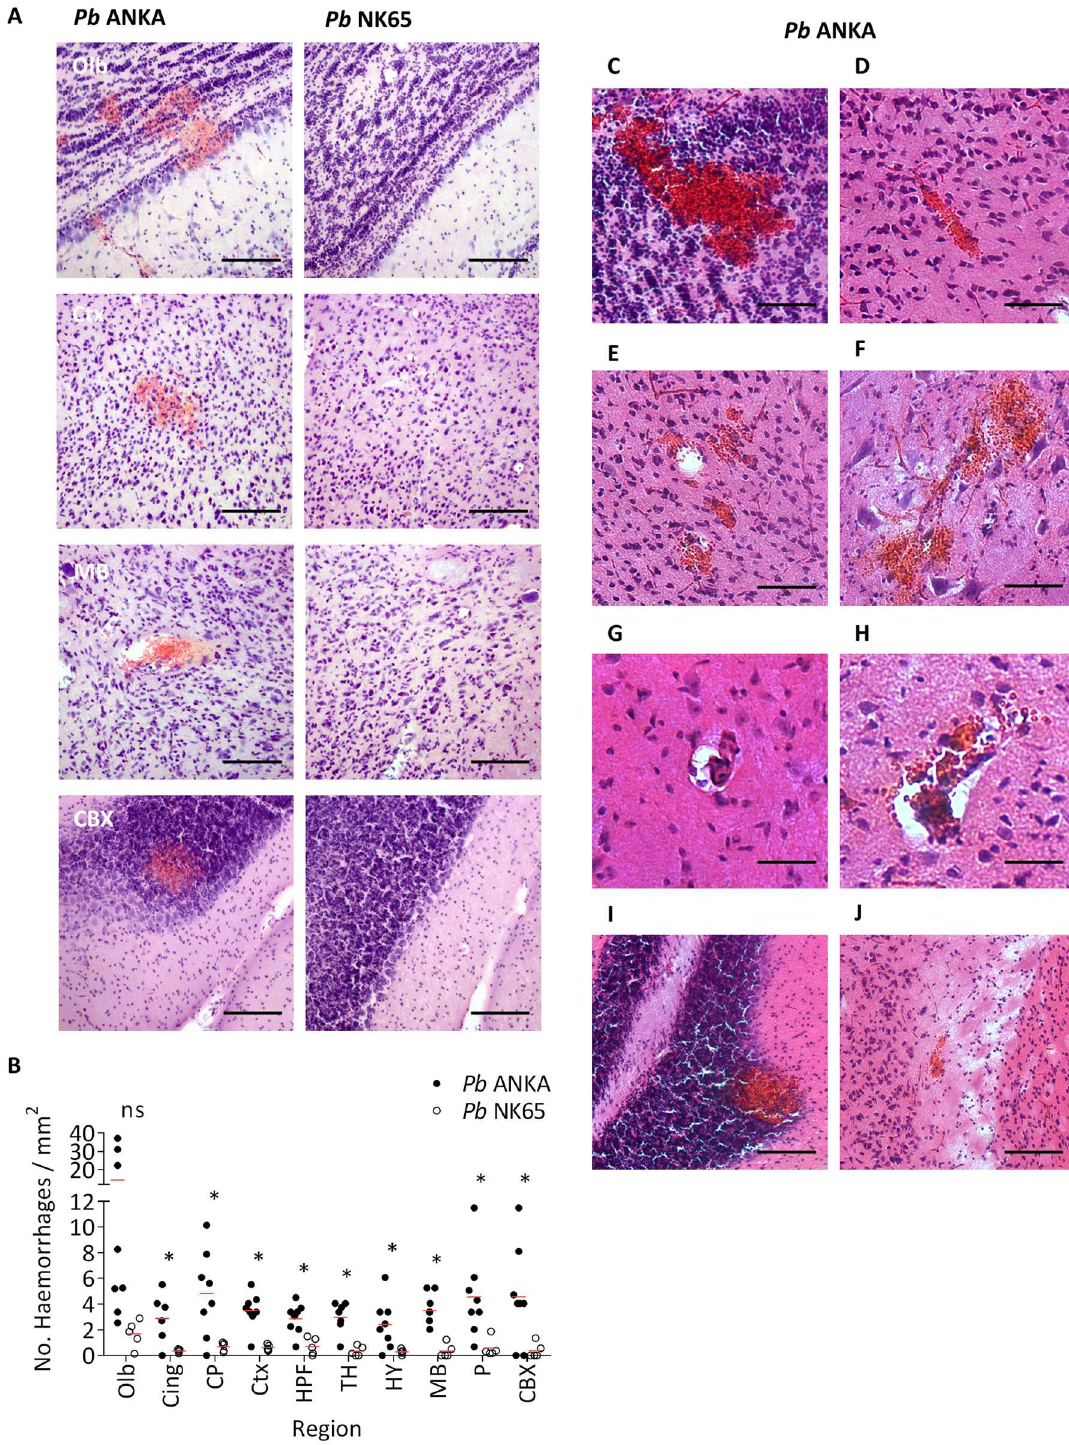
Fig 5. Incidence of intracerebral haemorrhage is greater during ECM infection compared to non-ECM infection. C57BL/6mice were infected with 1x10 4 Pb ANKA GFP (n = 8) or 1x10 4 Pb NK65 GFP (n = 5) pRBCs. Mice were culledat d7 p.i. when Pb ANKA infected mice exhibitedsigns of late-stage ECM. Brains were removedfrom transcardially perfusedmice and the nature and incidenceof haemorrhageexaminedhistologically via H&E staining. (A) Representative H&E images